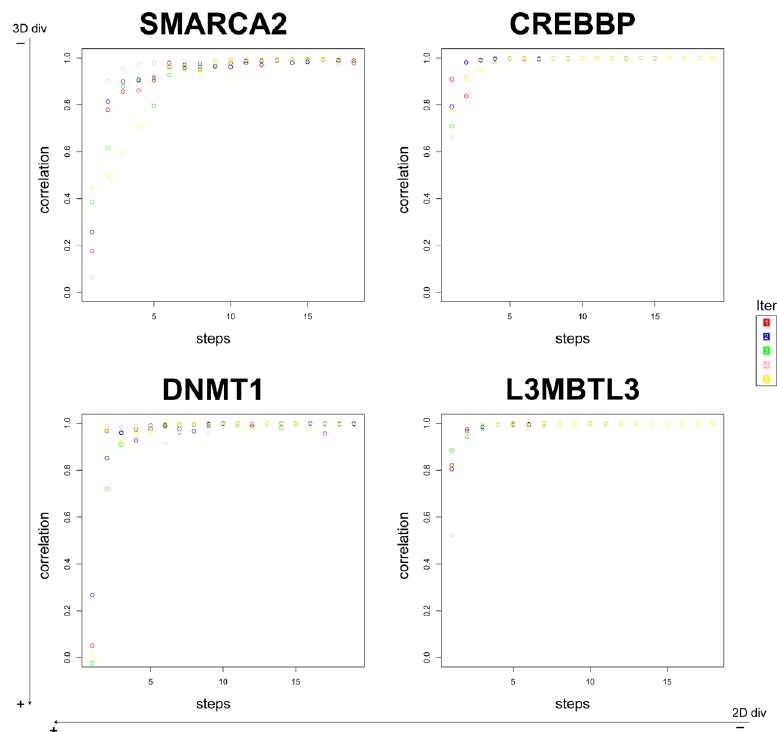
Figure 3. Forward analysis with 2PCs picking satellites at random step sizes of